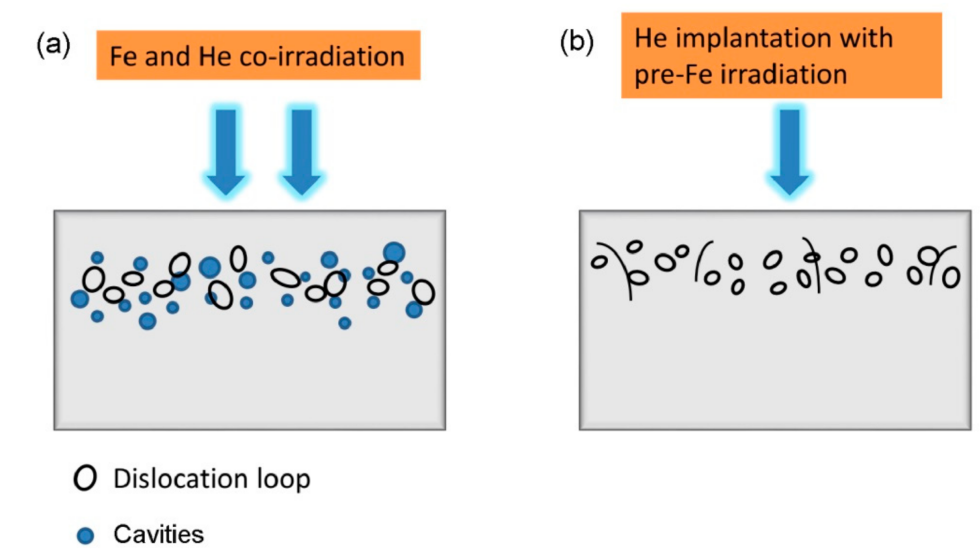
Figure 6. A schematic diagram showing microstructural defects in the Fe and He co-irradiated SIMP steel ( a ) or He implantation with Fe pre-irradiation into SIMP steel at 300 ◦ C ( b